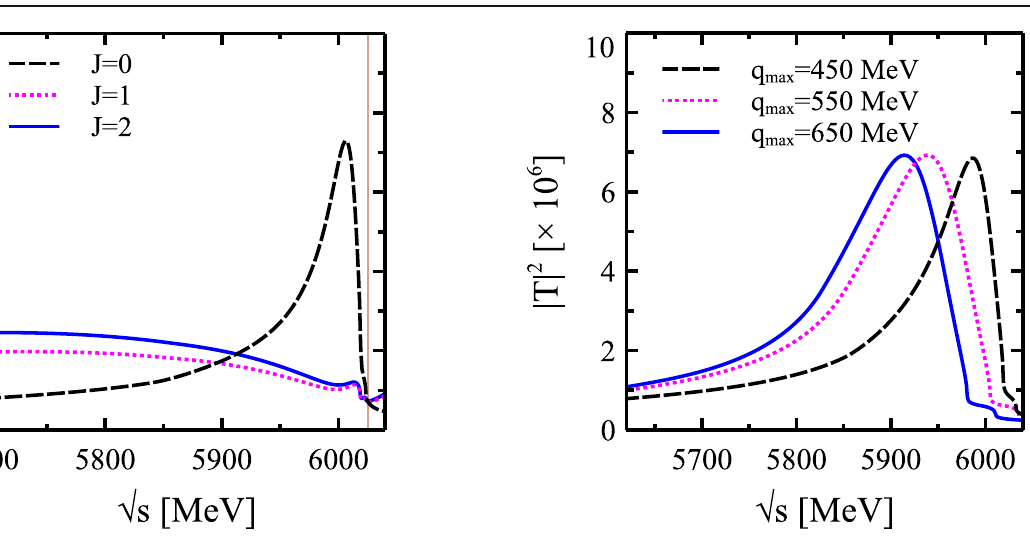
Fig. 3 Modulus squared of the three-body T -matrix as a function of √ s for J P = 0 − and q max = 450, 550 and 650 MeV